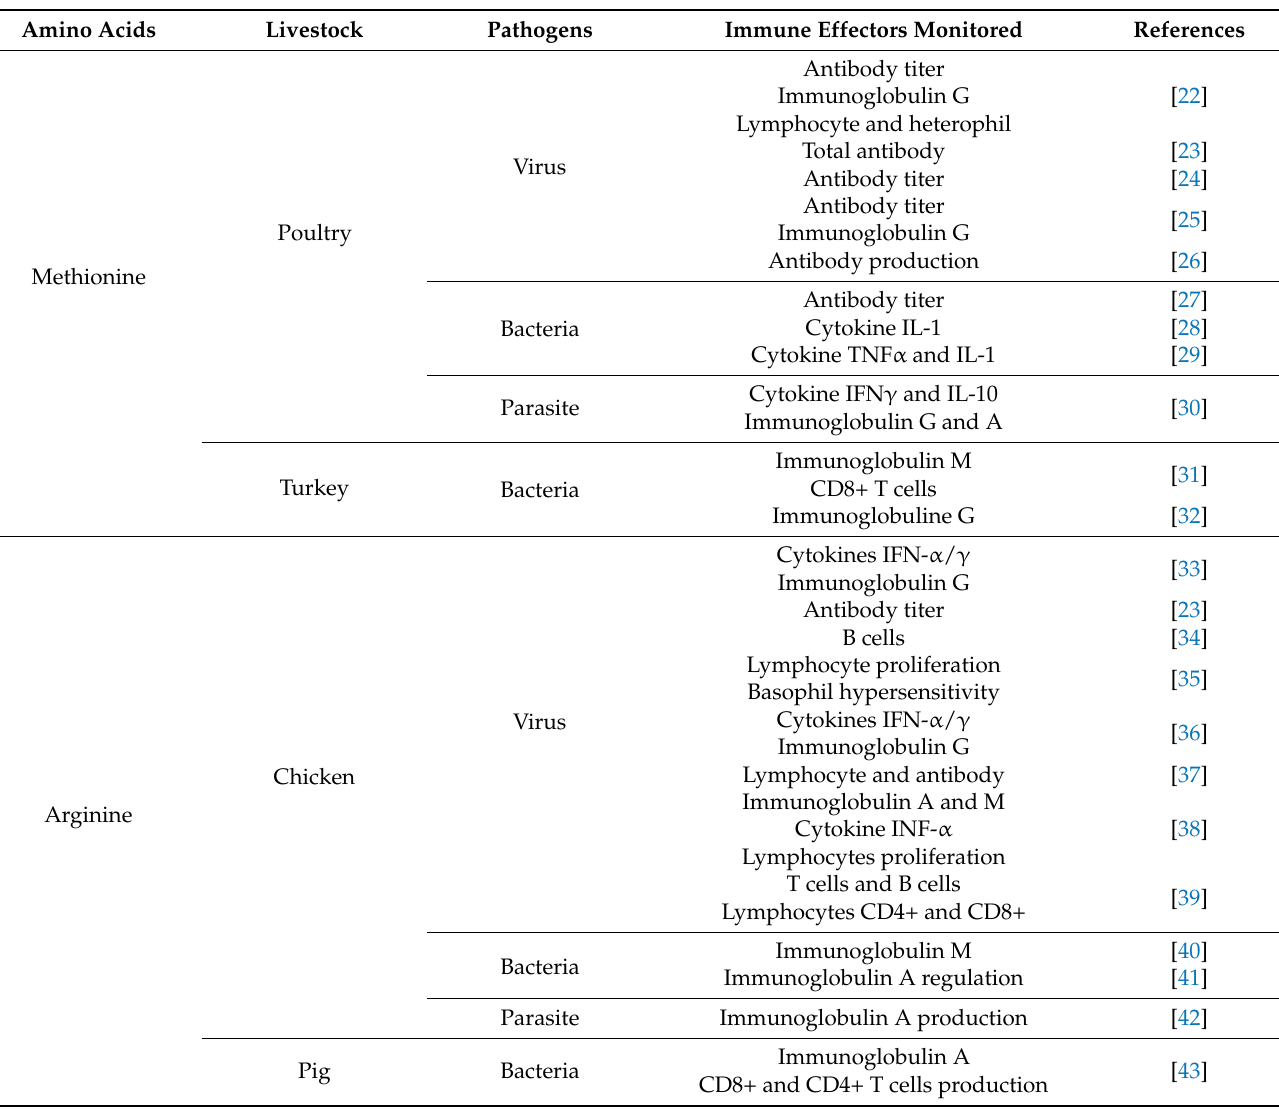
Table 2. Main amino acids impact on immune effectors in livestock during an infectious stress. Only studies showing a significant increased effector expression are